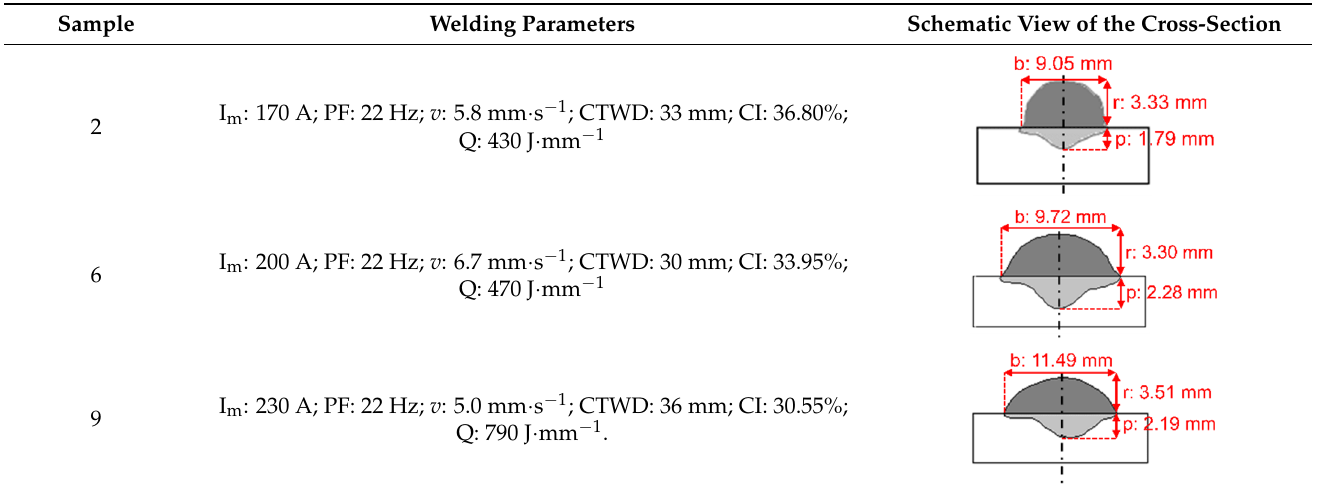
Table 4. Schematic morphology of the weld beads to the parameters selected. Where: penetration depth (p), reinforcement height (r), bead width (b), and convexity index (CI).